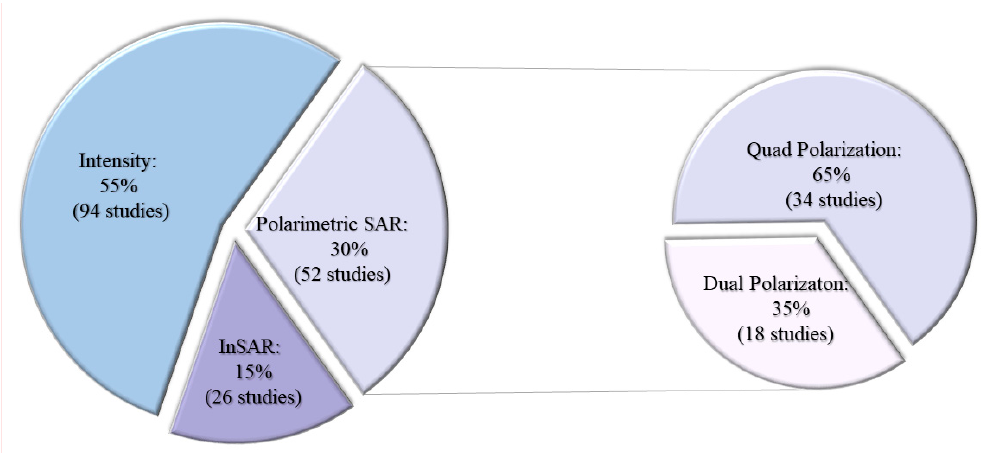
Figure 11. Summary of SAR information used by each study in the meta-analysis into three groups: backscattering intensity, polarimetry and interferometry. Studies using the polarimetric SAR information are further subcategorized into quad and dual polarizations.